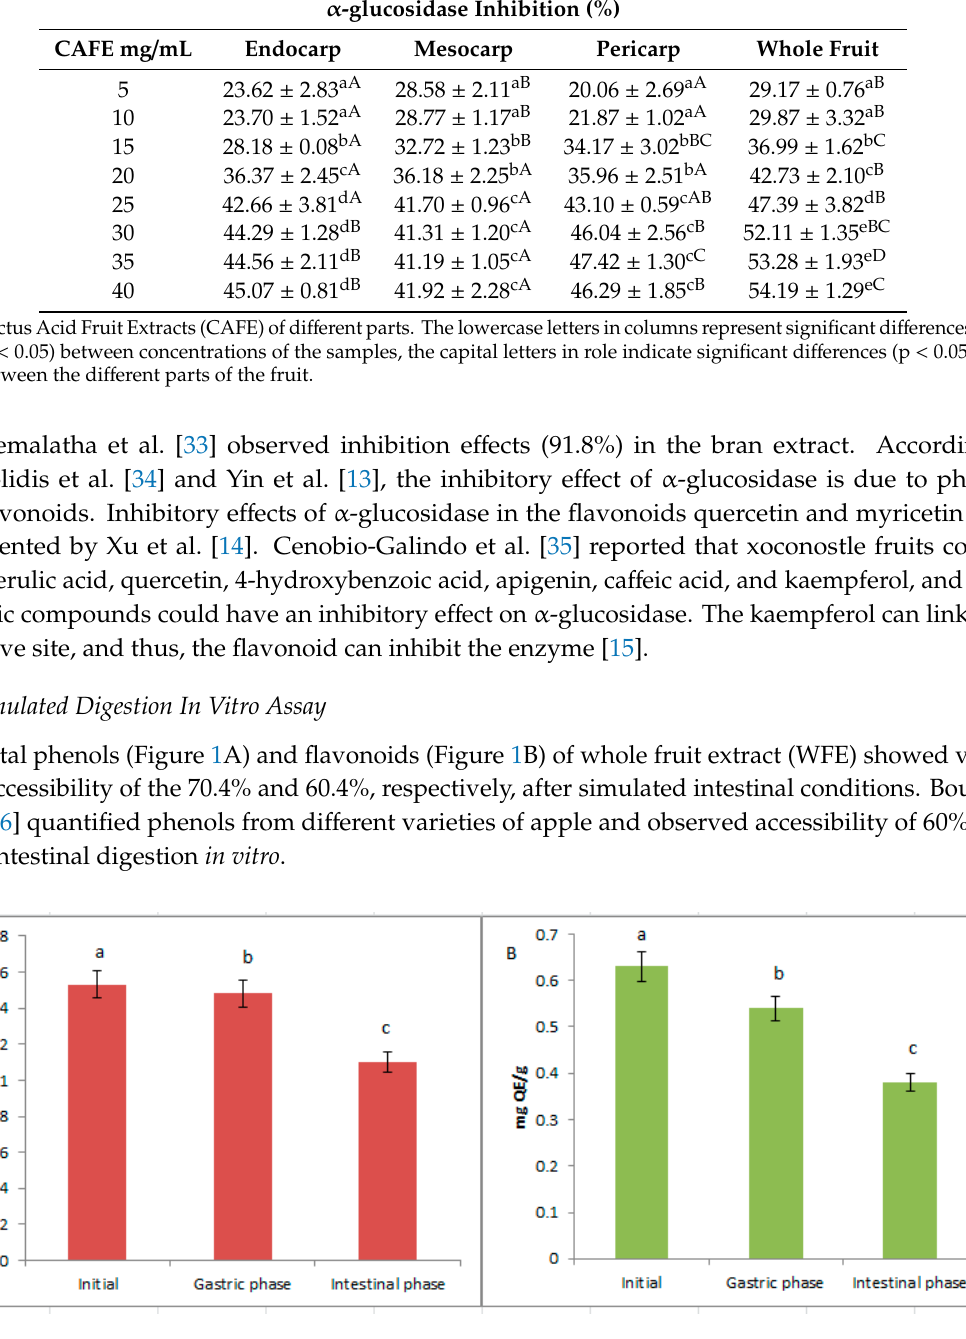
Table 3. Effect of the extracts from different parts of cactus acid fruit (endocarp, mesocarp, pericarp, and whole fruit) in the inhibition α -glucosidase enzyme.